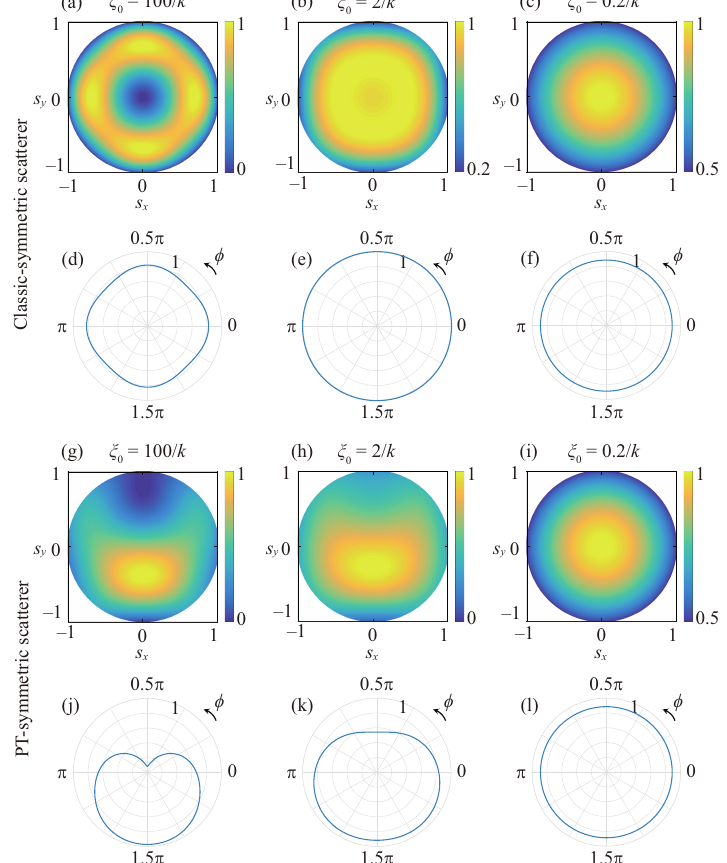
Figure 2. Simulation results for the total intensity Λ 0 ( r s , ω ) of the far-zone scattered field by a four-point scatterer having ( a – c ) classic-symmetric potential and ( g – i ) PT-symmetric potential. The curves shown in ( d – f ) and ( j – l ) denote the corresponding intensity distribution along the azimuthal angle φ with the polar angle fixed at θ = π /6. The spatial coherence width of the incident partially coherent beam is controlled by ξ 0